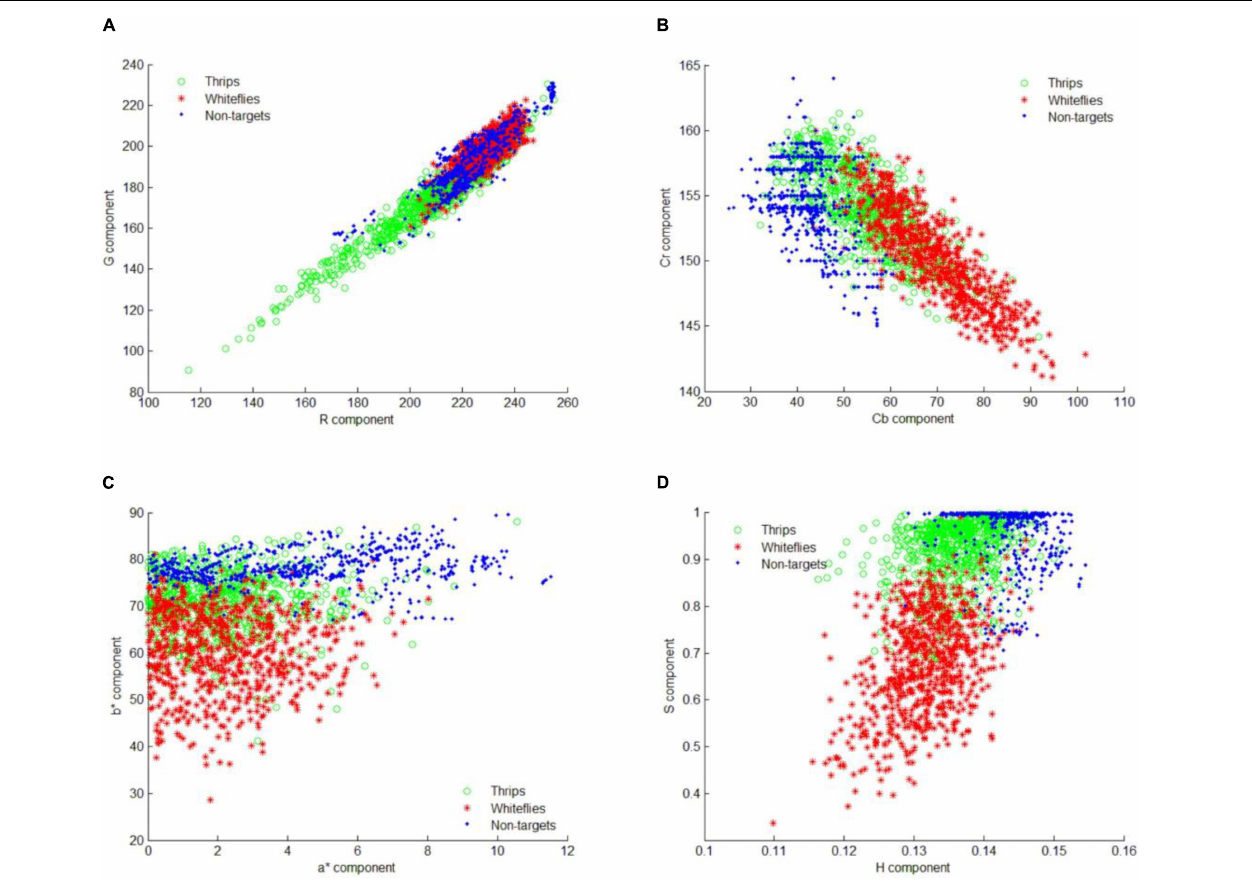
FIGURE 8 | Feature distribution of all the training samples. (A) Sample distribution in RGB color space, (B) sample distribution in L*a*b* color space, (C) sample distribution in YCbCr color space, and (D) sample distribution in HSV color